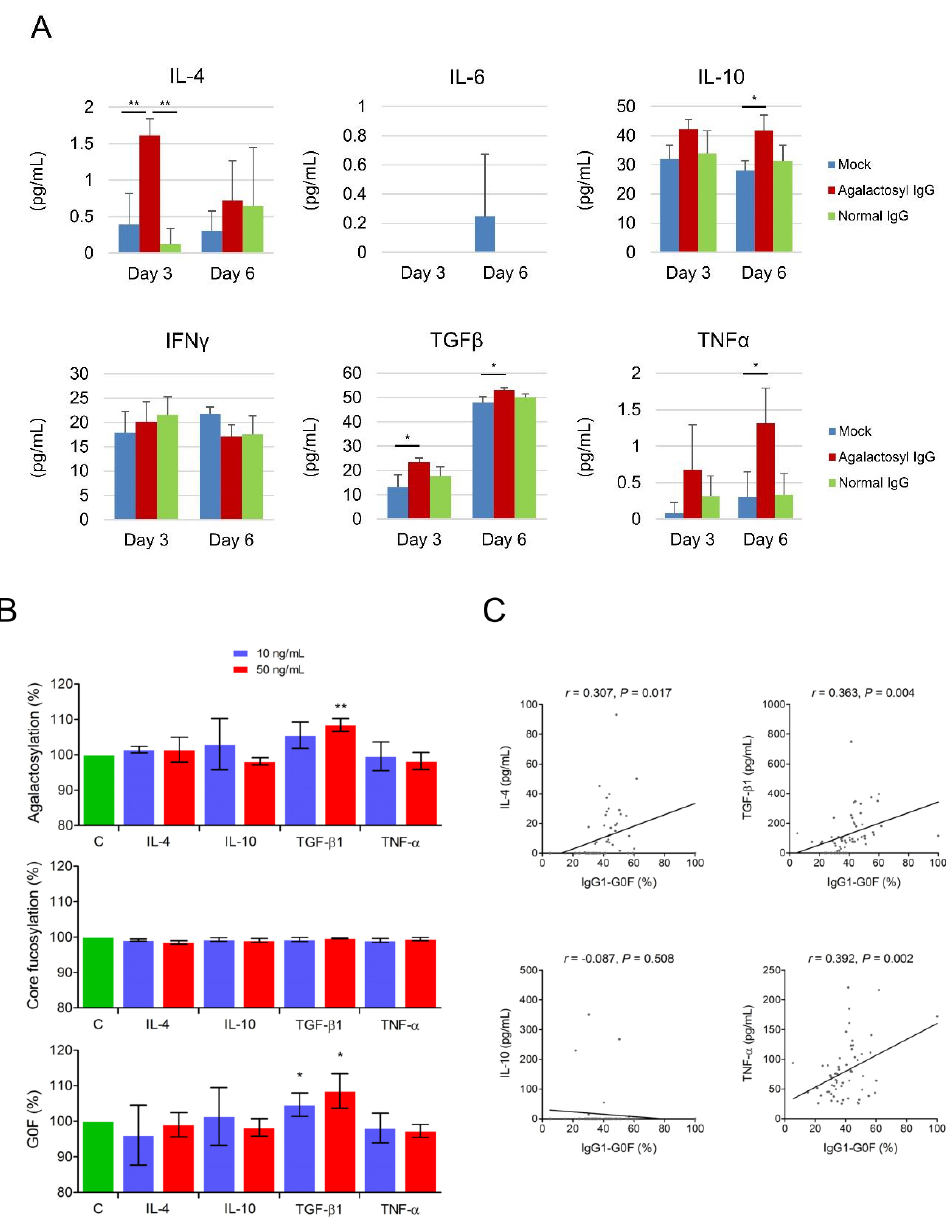
Figure 3. Regulation of IgG 1 -G0F. ( A ) Levels of tumor-associated macrophage-related cytokines in U-937 cells after treatments with 10 ng/mL of phorbol 12-myristate 13-acetate for 2 days and 10 mg/mL of IgG (blue bar, mock; red bar, agalactosyl IgG; green bar, normal serum IgG) for another 3 or 6 days, are shown in bar graphs as means with standard deviations. P -values are obtained from one-way analysis of variance with Scheff é post hoc tests. ( B ) Proportions of mouse IgG 1 agalactosylation, core fucosylation, and G0F glycoform from mouse hybridoma cells after 48 h of cytokine treatment are shown in bar graphs as means with standard deviations. Results are obtained from three independent experiments. Two-tailed Student’s t -tests are used for comparisons between treatment groups (blue bar, 10 ng/mL; red bar, 50 ng/mL) and the control (C, green bar). *; p < 0.05; **; p < 0.01 ( C ) Correlations between IgG 1 -G0F and various cytokines in serum from the patients with cholangiocarcinoma (n = 60) are shown. The coefficient r is taken from Pearson’s correlation test. Abbreviations: IgG-G0F, agalactosylated and core fucosylated IgG; IFN, interferon; IL, interleukin; TGF, transforming growth factor; TNF, tumor necrosis